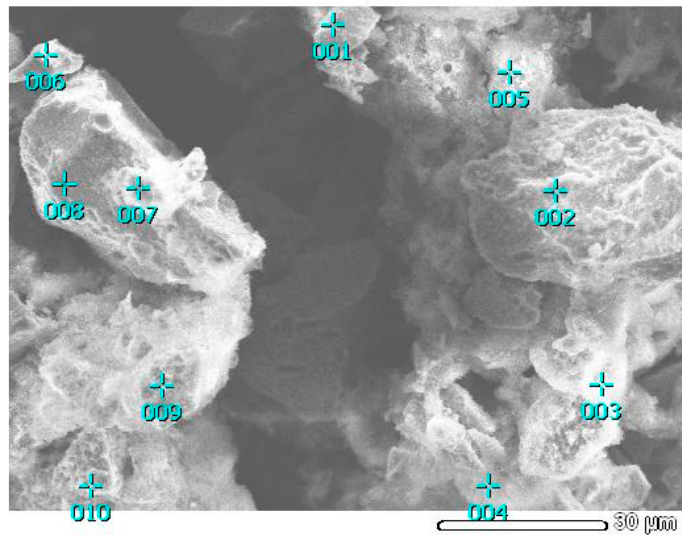
Figure 9. SEM images of the solid residue after synthetic concentrate dissolution in HNO 3 solution. (300 rpm; 353 K; 6 mol/L H 2 SO 4 ; 0.018 mol/L Fe (III); 15 min). Table 2. Normalized EDX analysis results.